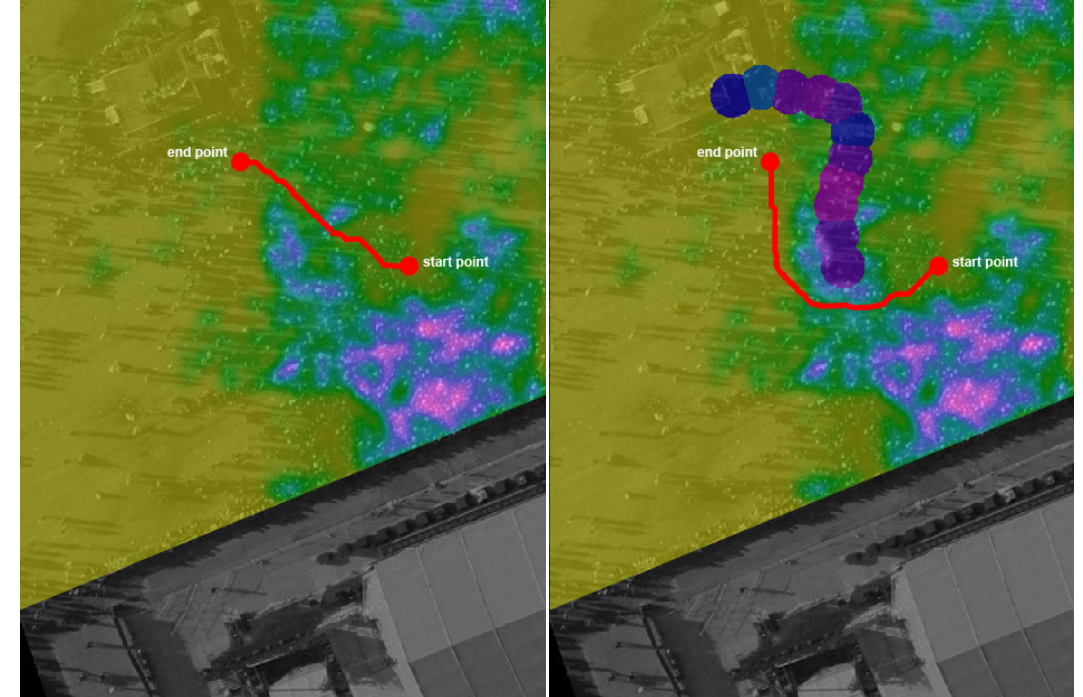
Figure 7. Resulting least-cost paths (red line) based on the original cost layer derived from the aerial image only ( left ) and with the additional cost information (circles) derived from smartphone sensor data ( right ). The background consists of the two cost layers over the corresponding aerial image scene. One main stage of the music festival is located in the lower right of both